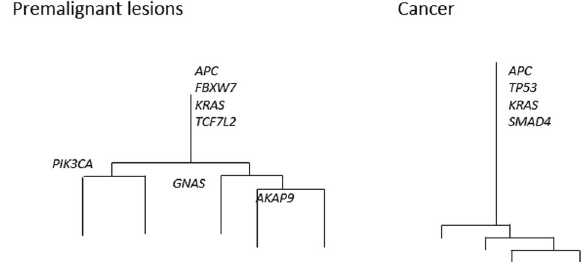
Fig. 1 Representative dendrogram showing differences in the distribution of mutations in premalignant lesions, and cancer. In ( a ) premalignant lesions, the trunk tends to be shorter with multiple branches, suggesting the presence of multiple subclones. In ( b ) cancer, the trunks are longer, demonstrating that cancer cells tend to be clonal. These dendrograms are adapted from Cross et al.